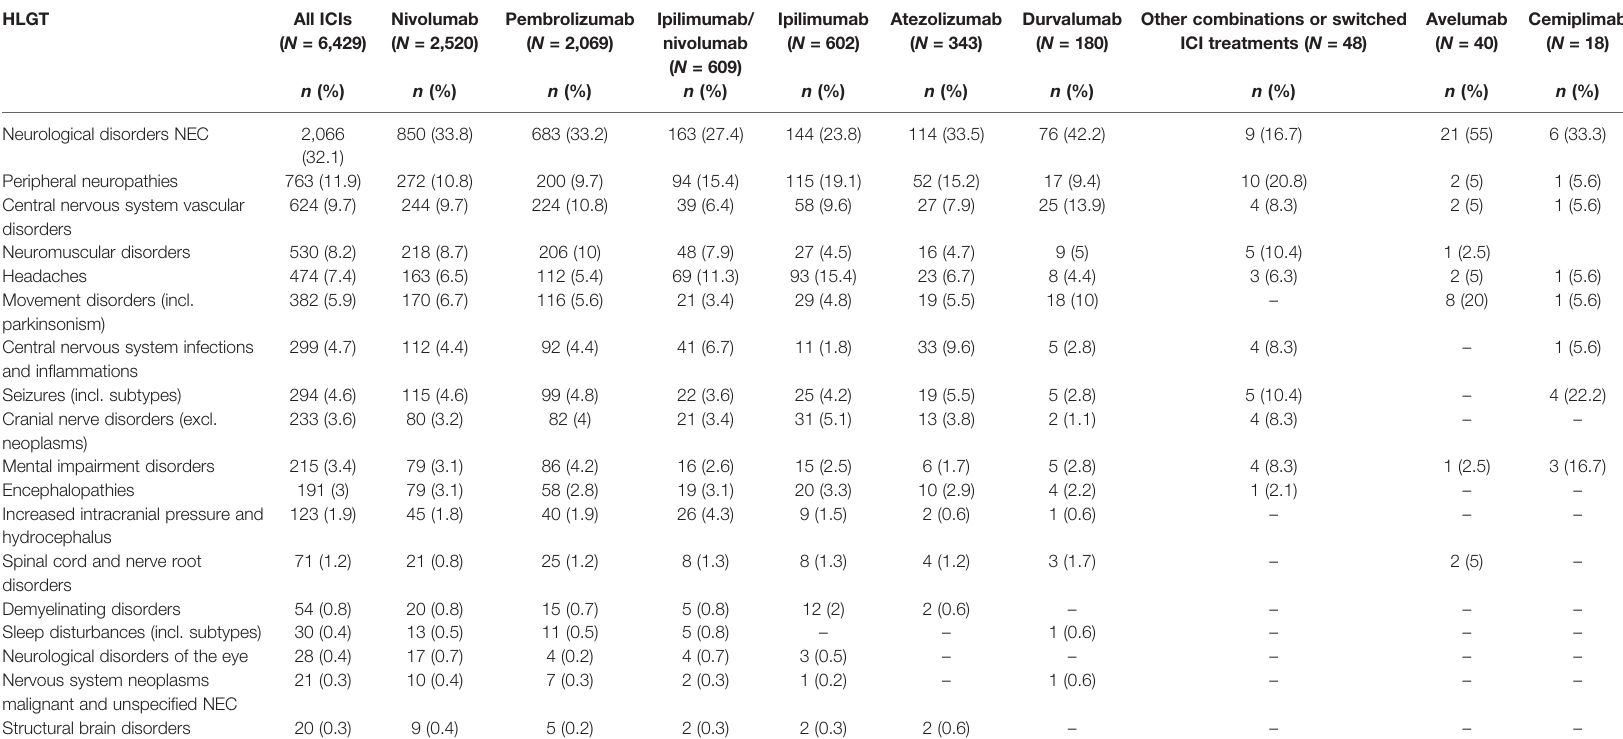
TABLE 4 | Neurologic outcomes occurring in European cancer patients treated with one or more ICIs, collected in EudraVigilance until February 7, 2020, categorized by HLGTs and administered ICI treatments.